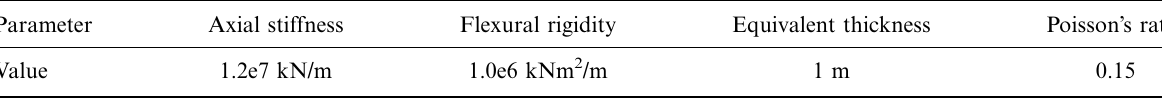
Table 2. Support wall properties used for finite element